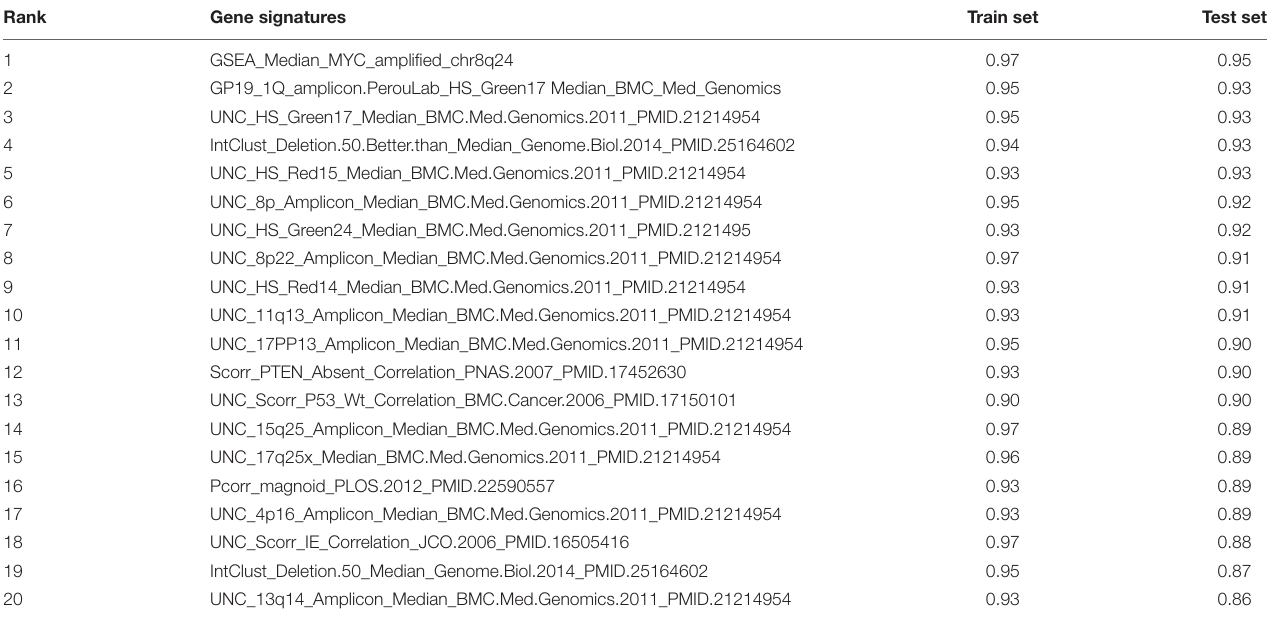
TABLE 3 | Top 20 AUC value of gene signatures predicted by Elastic Net